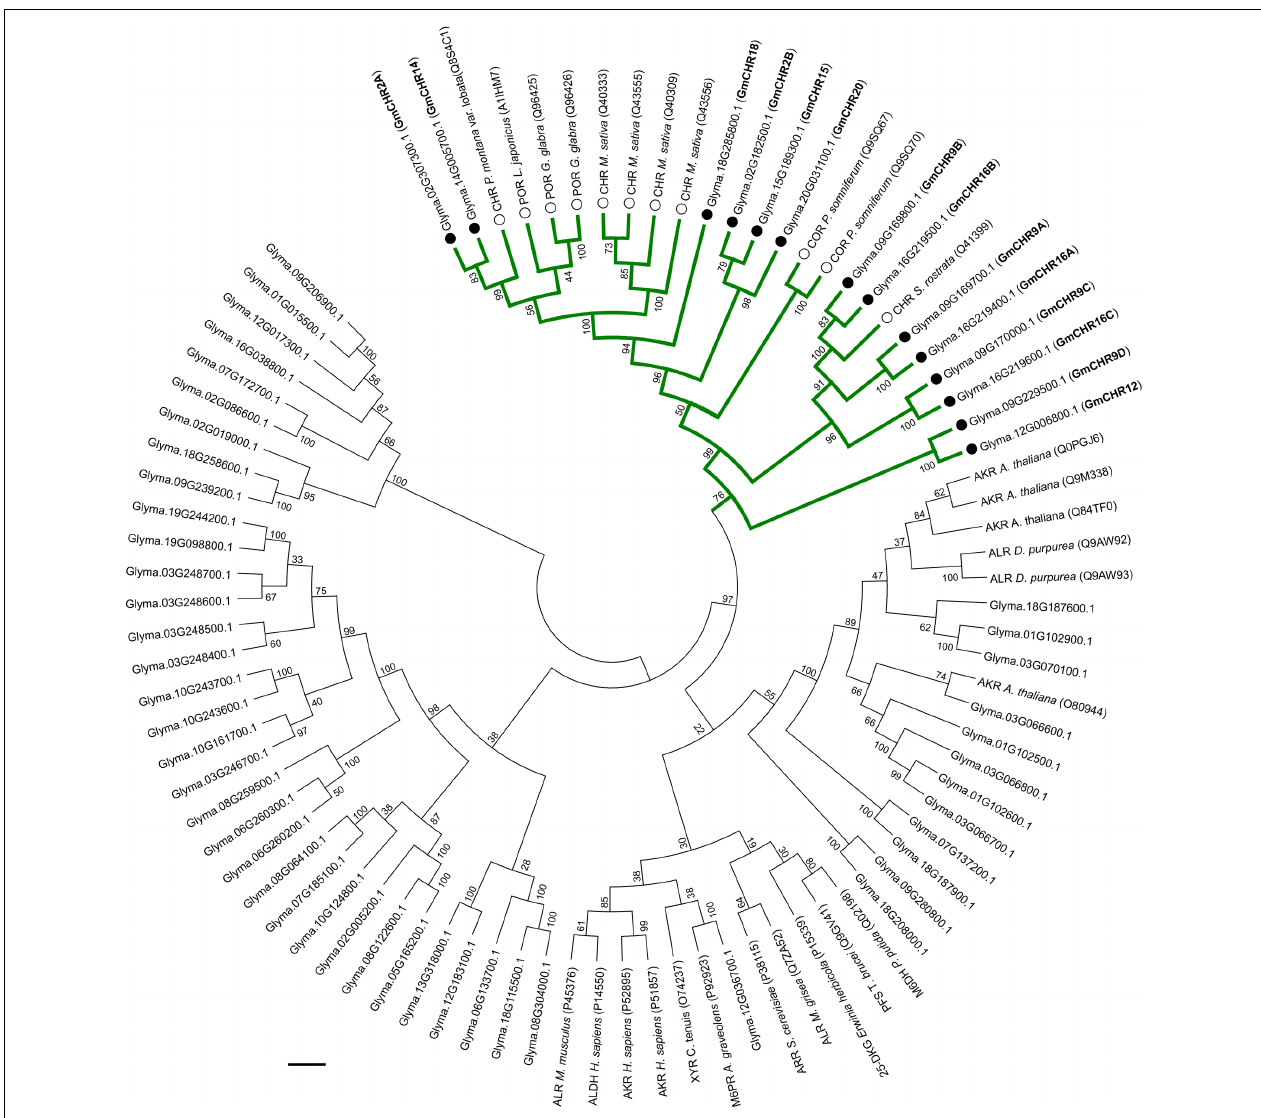
FIGURE 2 | Phylogenetic analysis of GmAKRs and GmCHRs. The deduced amino acid sequences of putative GmAKRs and known AKRs from other plant species were aligned using CLUSTALO and the Neighbor-joining tree was constructed using MEGA7 software. The green branch indicates CHR-specific AKRs, black